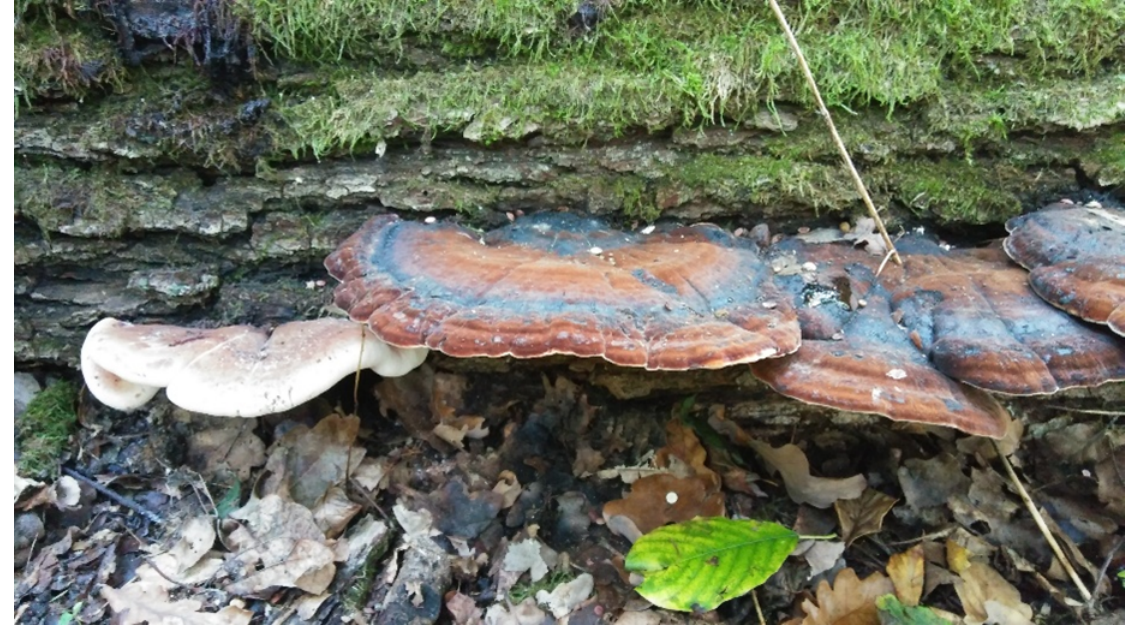
Figure 5 Basidiomata of Ischnoderma resinosum from Kampinos National Park; October 9, 2021. Photography by A. Szczepkowski.